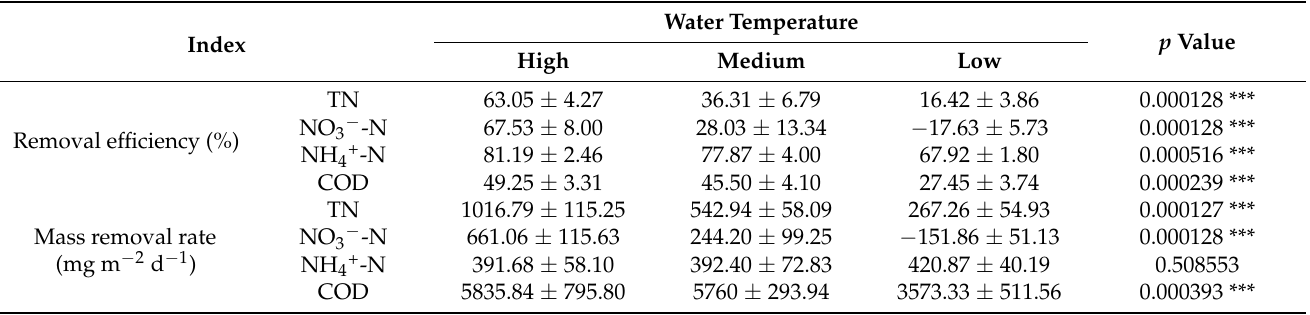
Table 1. Water purification efficiency of the MSSFCW system and statistical tests at different